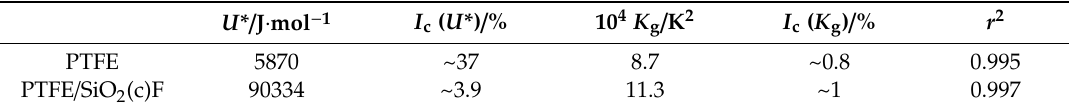
Table 2. Estimation of U * and K g parameters for PTFE and PTFE / SiO 2 (c)F on the BC